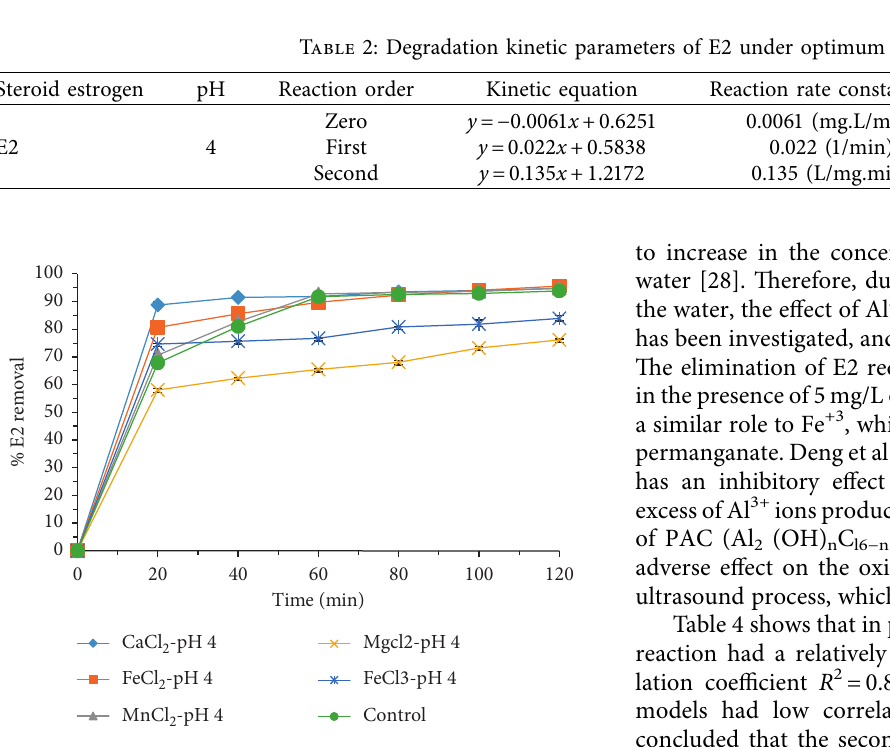
Figure 2: Removal percentage of E2 in the presence of coexisting materials for optimum